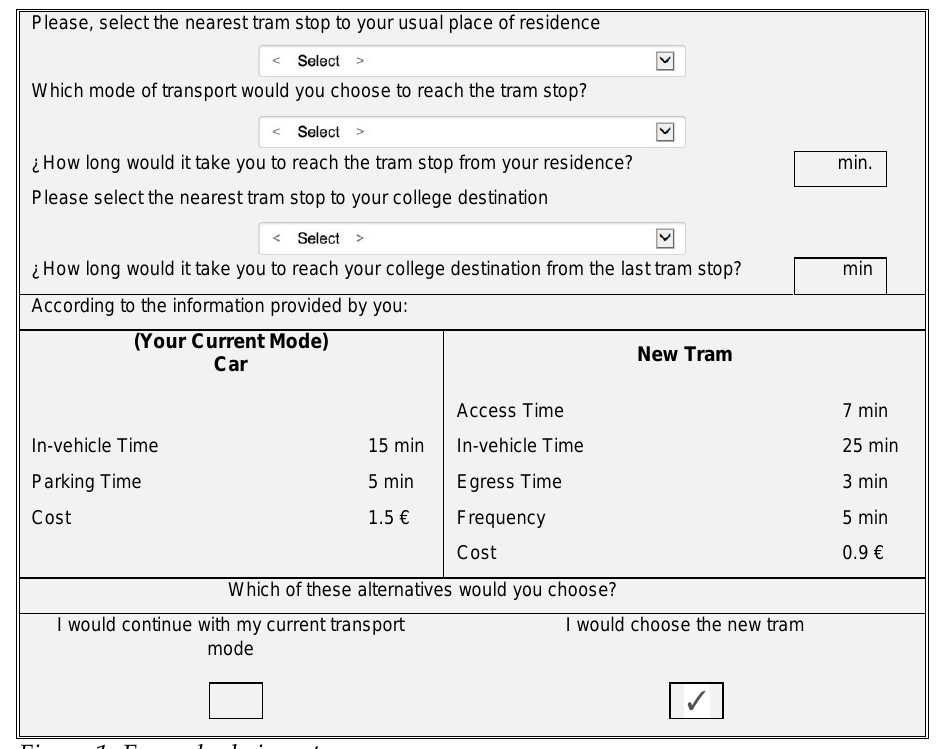
Figure 1. Example choice set